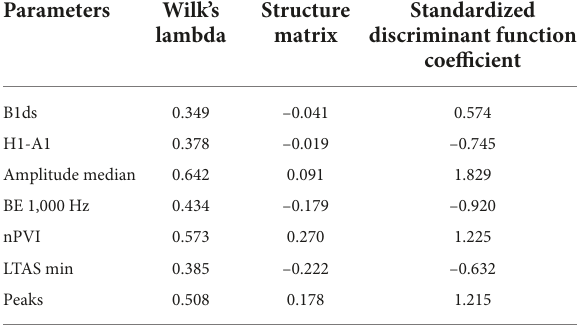
TABLE 2 Characteristics of the discriminant function for diabetes.